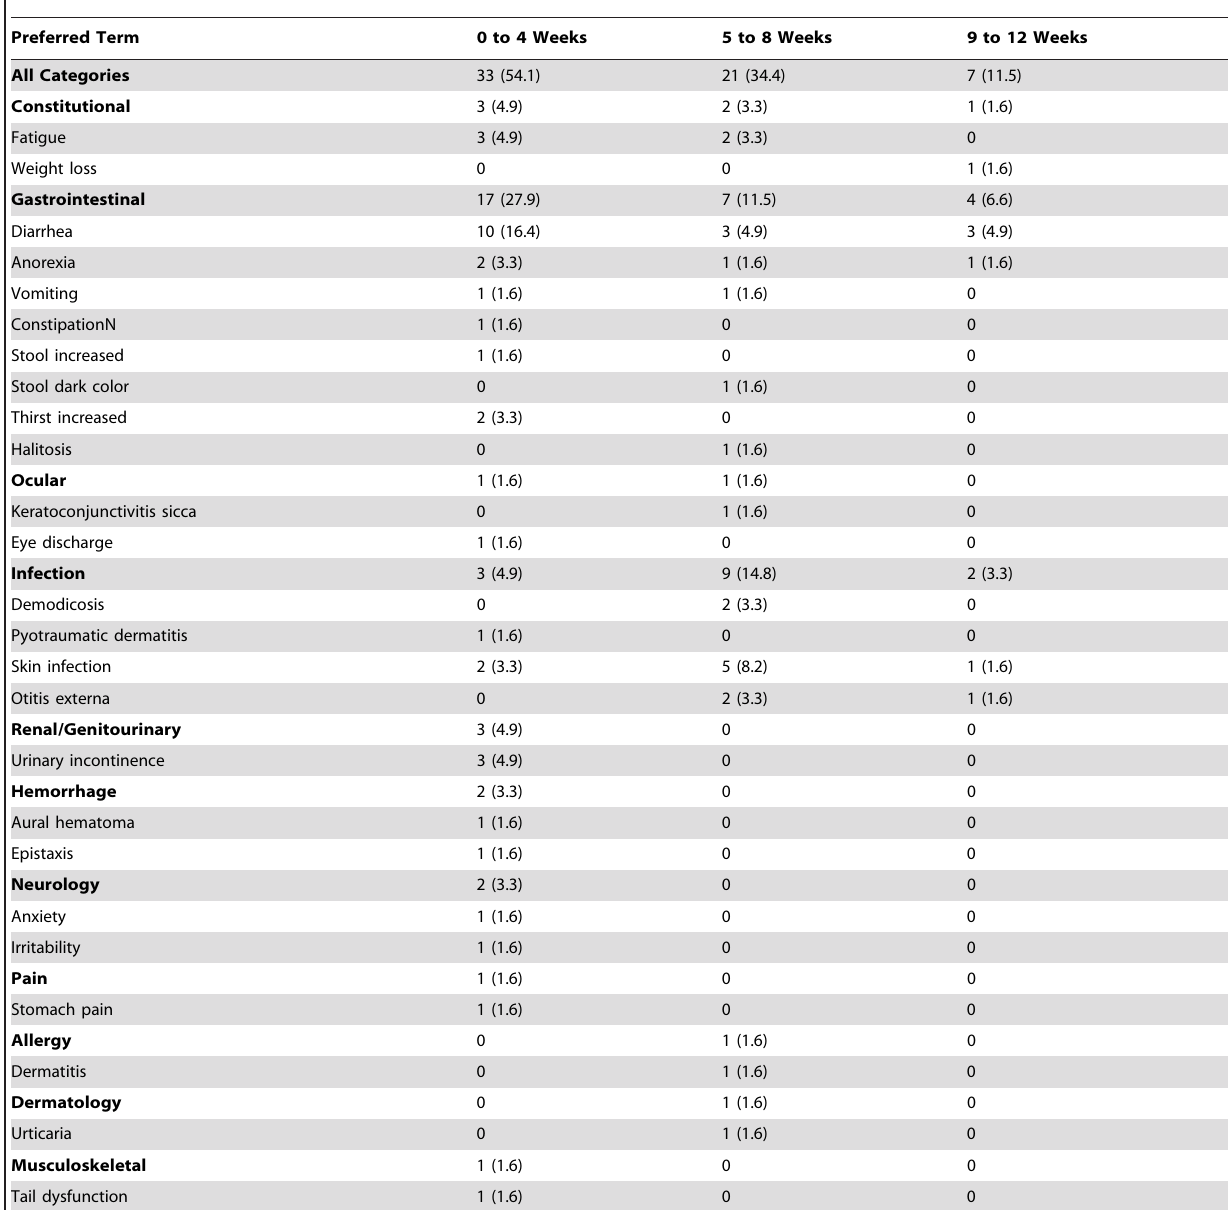
Table 5. Summary of clinical AEs as a function of 4-week intervals a